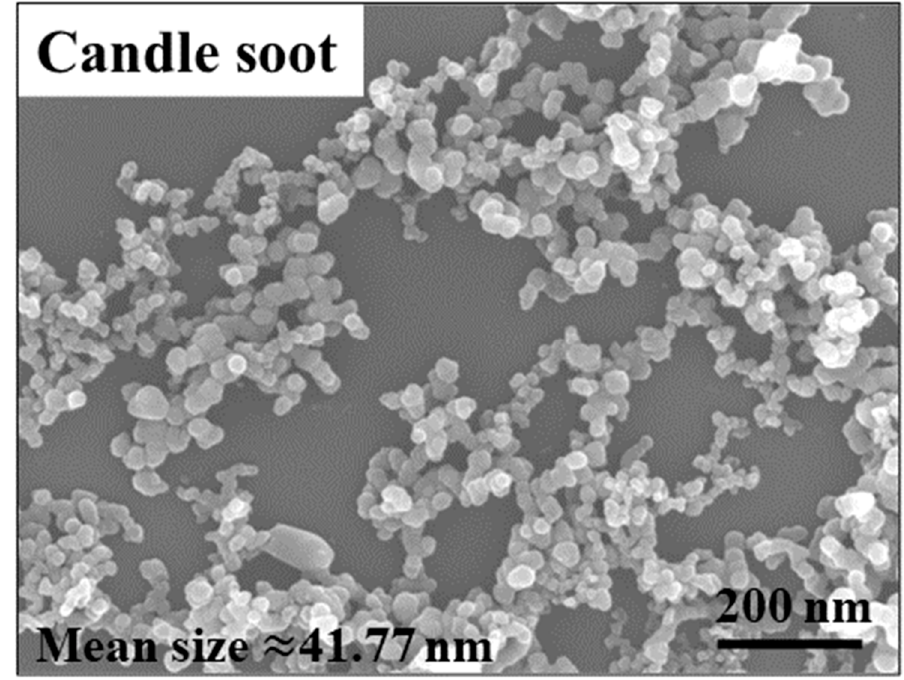
Figure 1. SEM of candle soot.